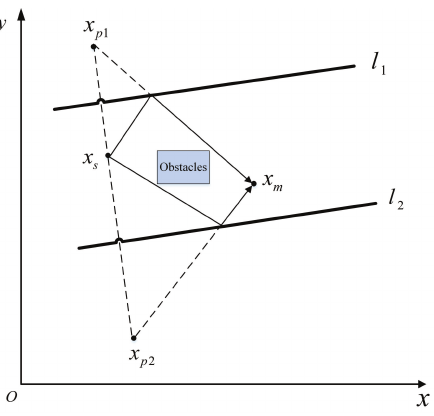
Figure 1. Single-bounce reflection paths and virtual